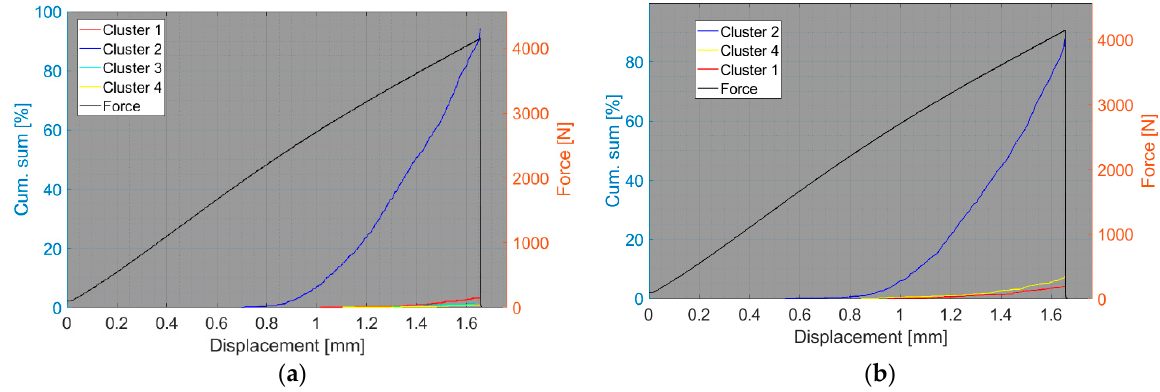
Figure 25. Cumulative sum of hits of individual clusters, including force versus displacement—CPT samples: ( a ) Fujicera 1045S dataset; ( b ) DWC 454 dataset.